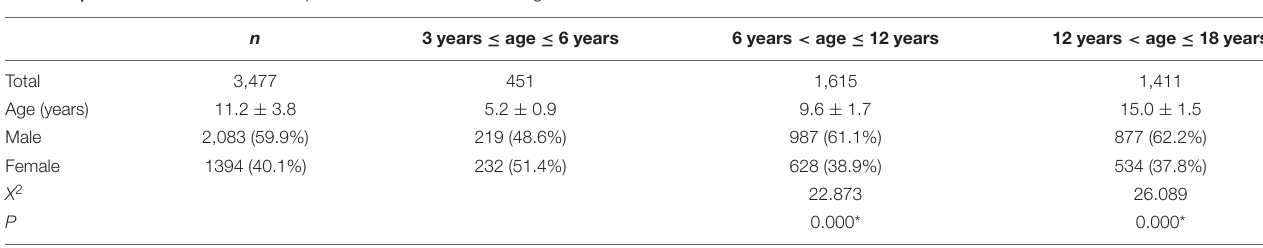
FIGURE 1 | Frequency histogram of age and sex among patients with chest pain ( n = 3,477). Of all 3,477 patients with chest pain, 2,083 (59.9%)were male, 1,394 (40.1%) were female, mean age was 11.2 ± 3.8 years. TABLE 1 | The sex distribution of chest pain in children with different